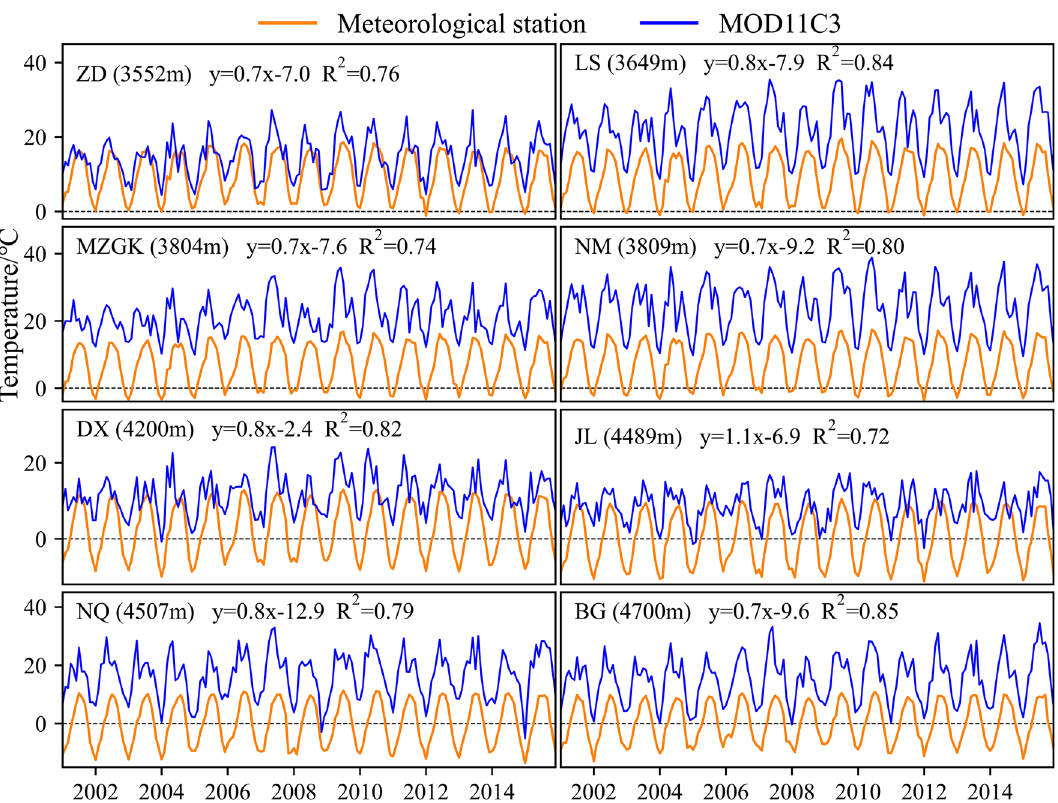
Figure 2. Comparison of air temperature of eight MET stations with corresponding gridded LSTemp of MOD11C3 from 2001 to 2015. Taking air temperature as y and LSTemp as x, the linear equation for each combination was fitted and marked as text in the